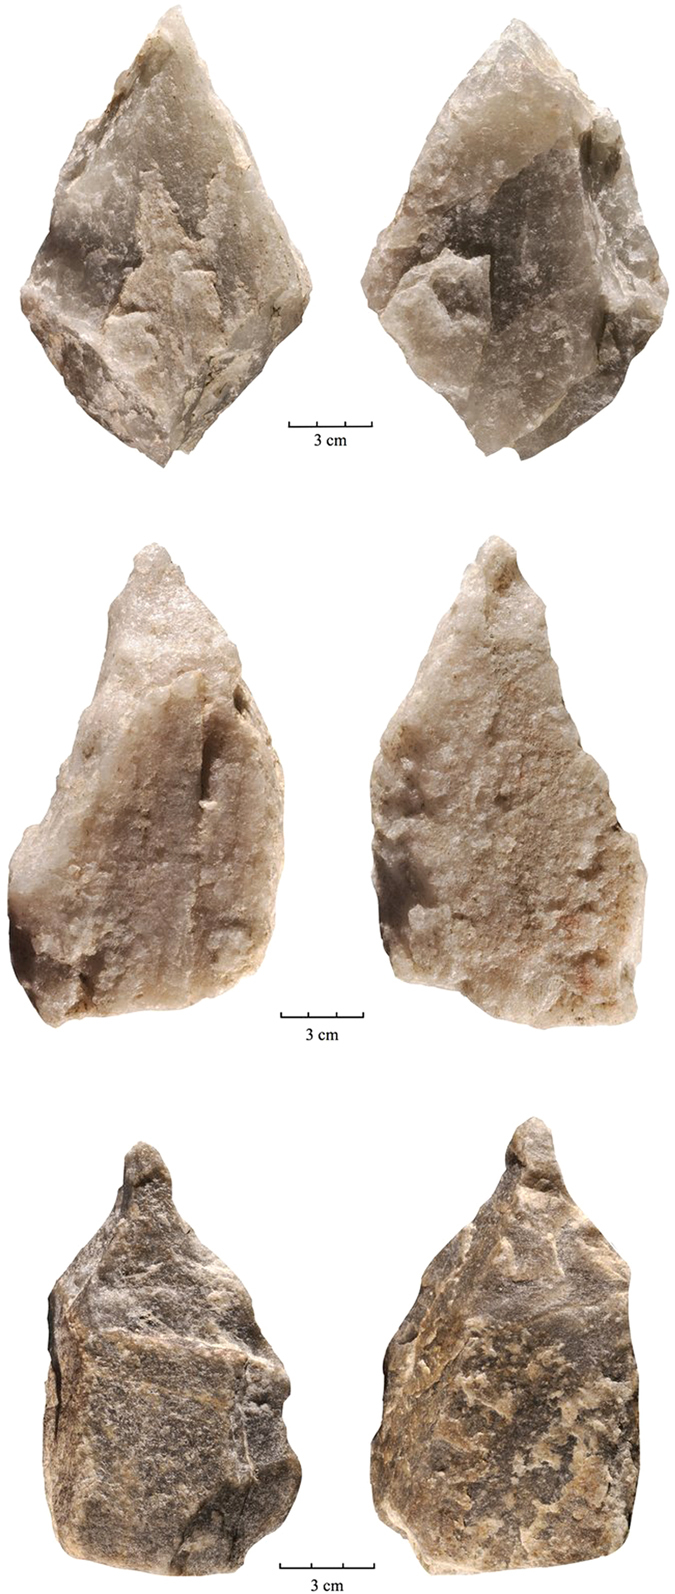
Quartz LCTs recovered from FLKW L53 and L612.Photo by F. Diez-Martín.